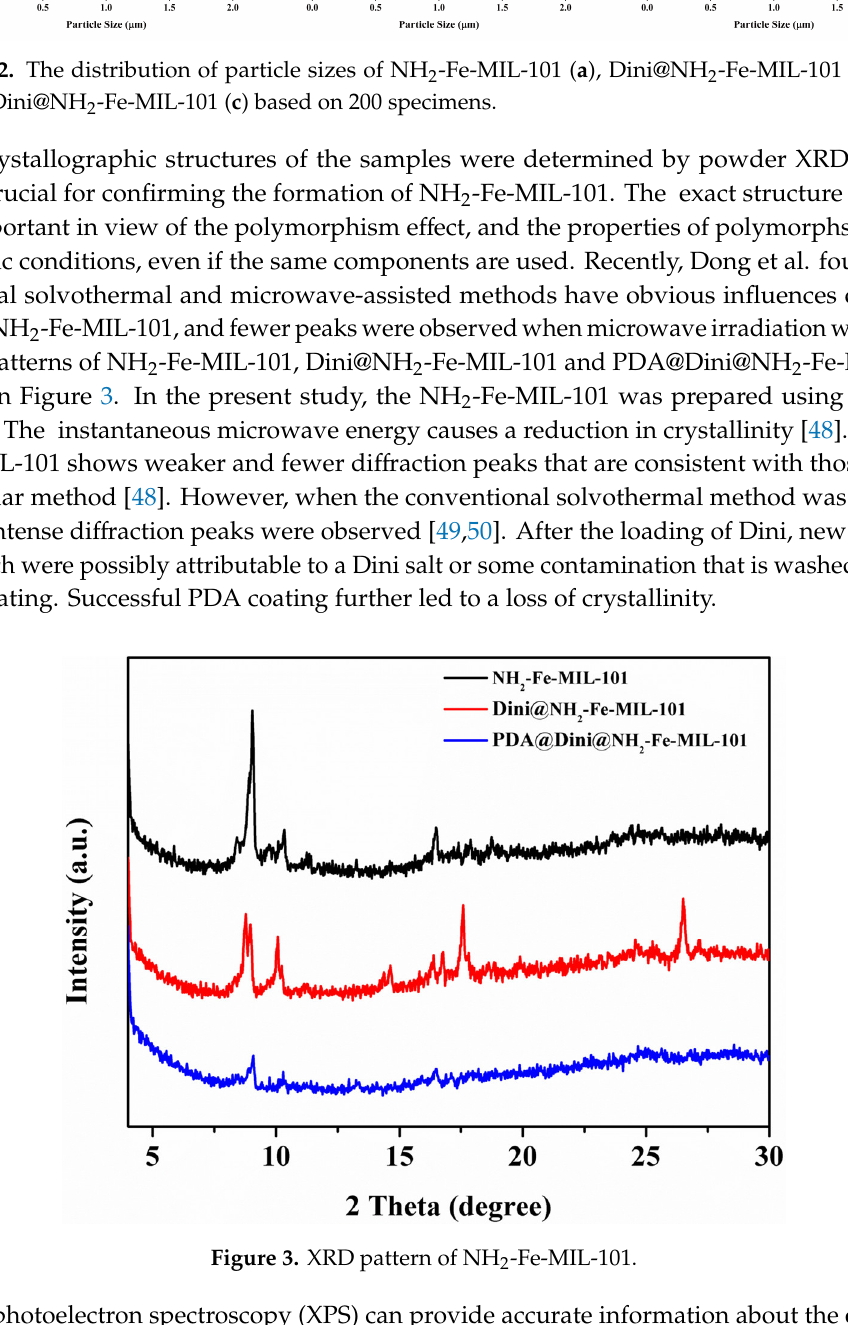
Figure 2. The distribution of particle sizes of NH 2 -Fe-MIL-101 ( a ), Dini@NH 2 -Fe-MIL-101 ( b ) and PDA@Dini@NH 2 -Fe-MIL-101 ( c ) based on 200 specimens.